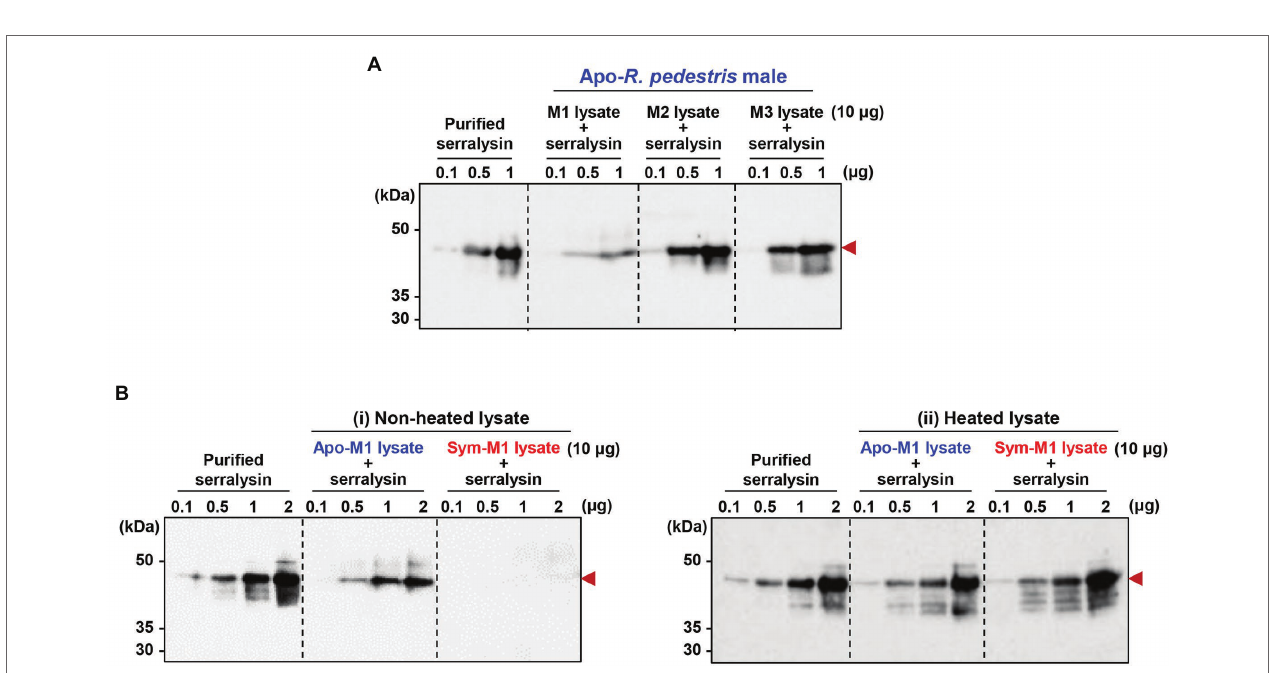
FIGURE 4 | Inactivation of serralysin by midgut lysates. (A) Immunoblot patterns after co-incubation of purified serralysin with M1, M2, and M3 midgut lysates of insects without gut symbionts (Apo-insects). (B) Immunoblot patterns after co-incubation of purified serralysin with M1 midgut lysates of Apo- and Burkholderia - colonized insects (Sym-insects). M1 extracts were prepared (i) without and (ii) with heat treatment, respectively. The reaction conditions were as follows: In total, 10 μ g of each midgut lysate was incubated with different concentrations of purified serralysin for 1 h at 28 ° C. Arrowheads indicate the bands of purified